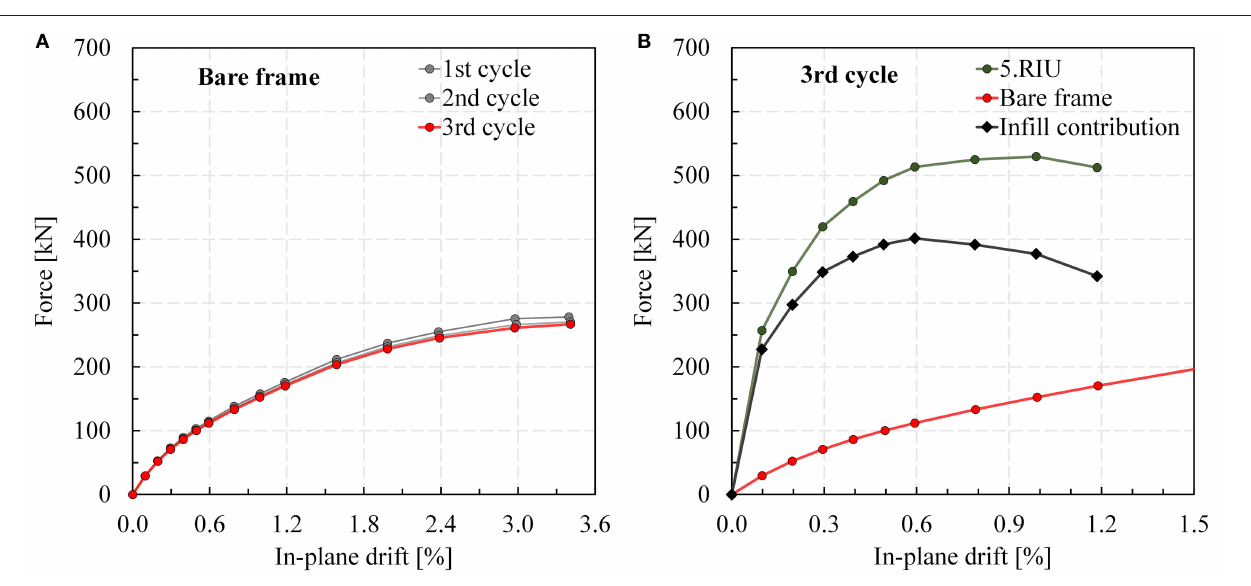
FIGURE 10 | In-plane load-drift envelope curves of bare frame (A) ; infill wall contribution by subtraction (B)